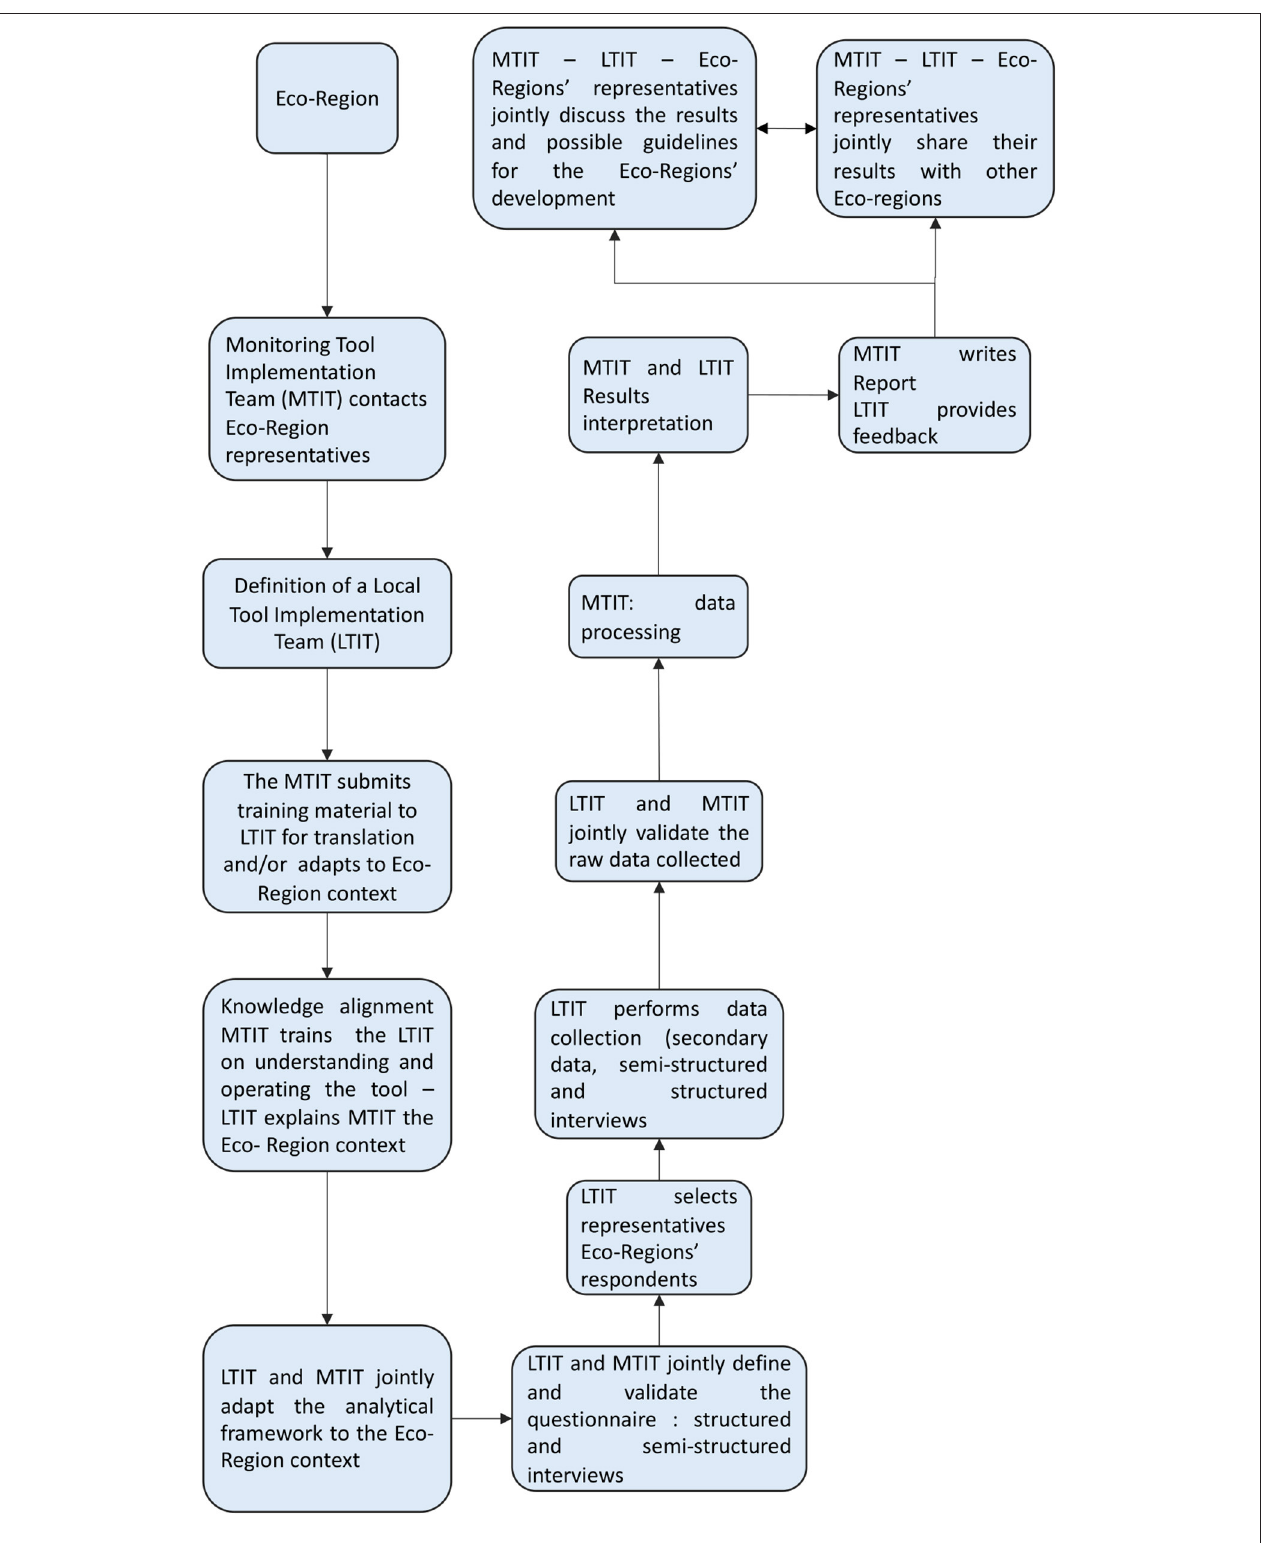
FIGURE 6 | Eco-Regions’ implementation activity action